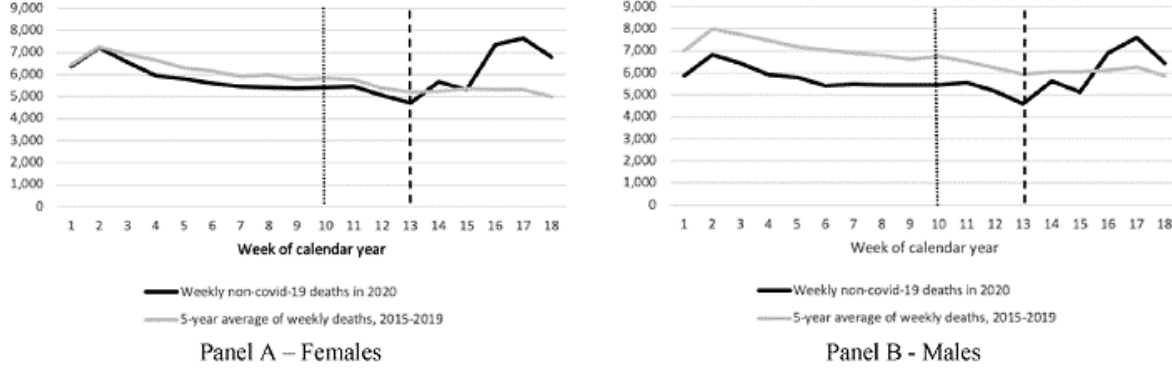
Figure 3. Weekly deaths, by gender, recorded in England and Wales as unrelated to COVID-19 compared to the 2015-2019 weekly average. The dashed vertical line indicates the first recorded death from